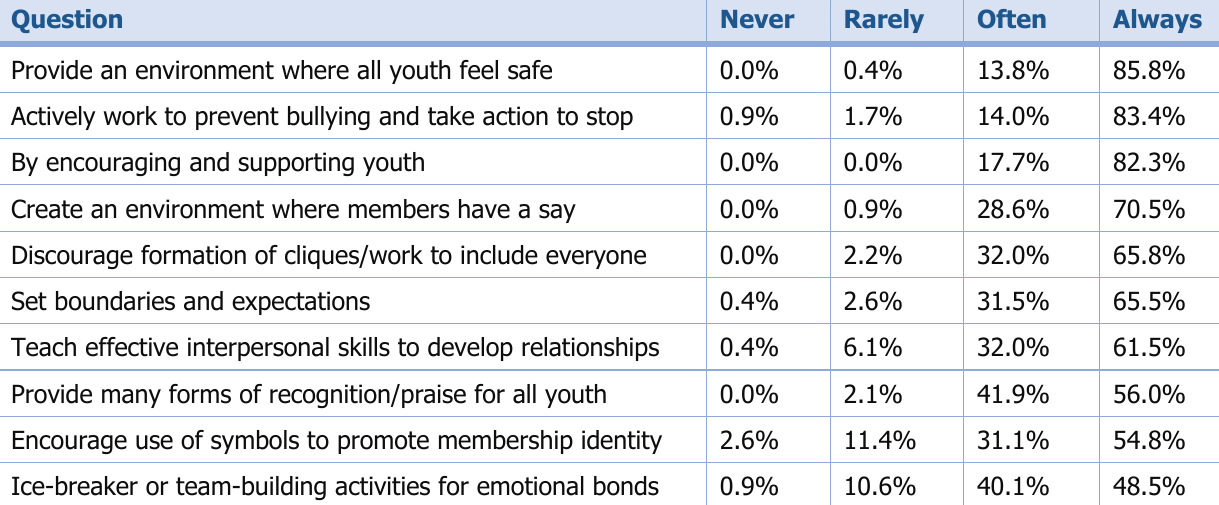
Table 2. Frequency of Volunteer Responses to Questions on Practices That Promote